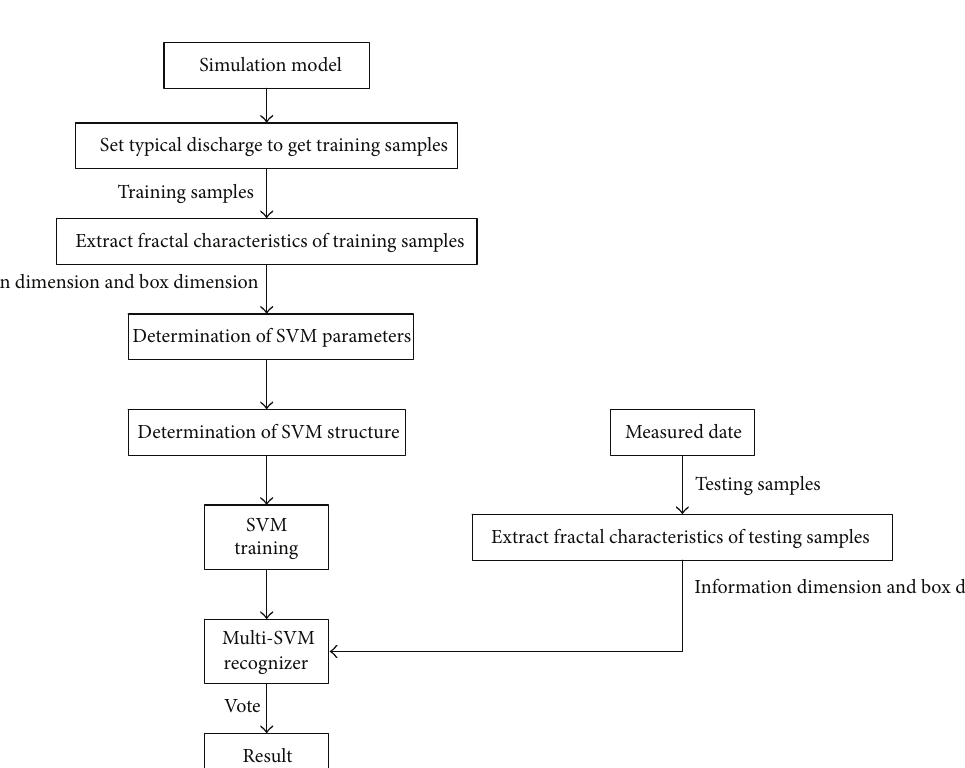
Figure 6: Flowchart of SVM